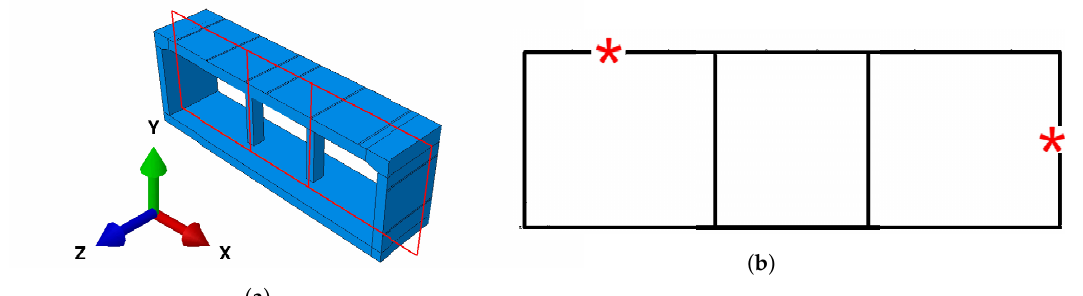
Figure 19. Positions at which measurements of strains were carried out during testing: ( a ) perspective representation and ( b ) cross-section, coinciding with the plane of symmetry of the structure that contains the